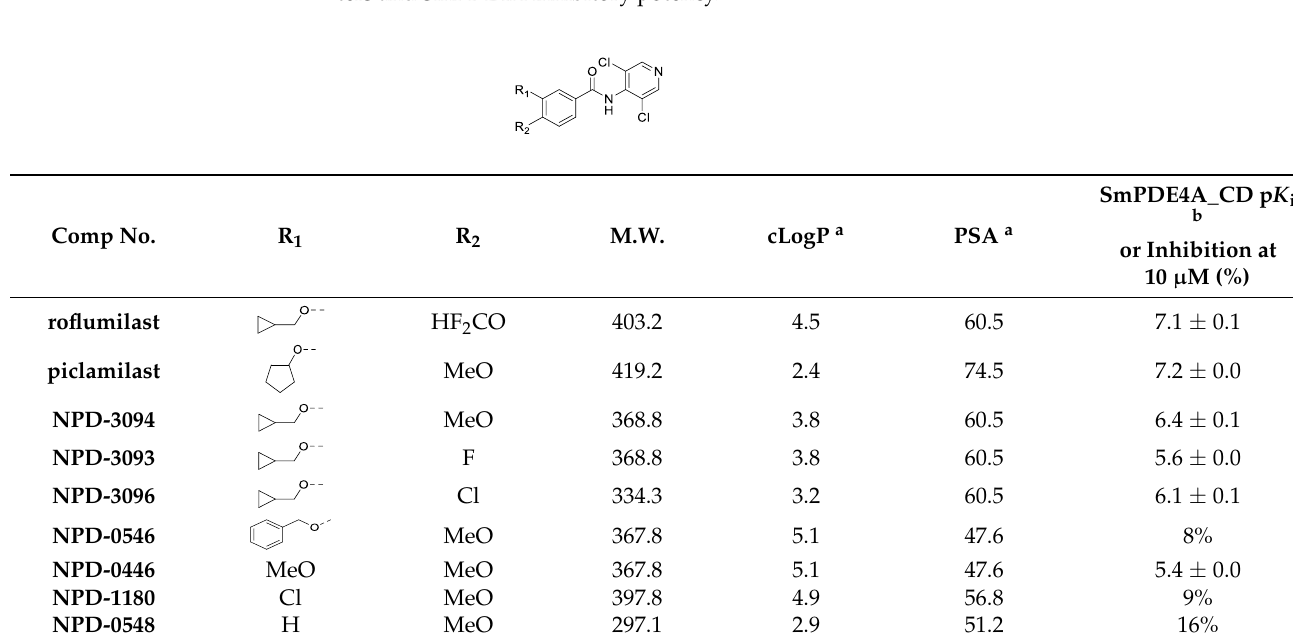
Table 2. Variations of the R 1 and R 2 groups of roflumilast and the effect on physicochemical param- eters and SmPDE4A inhibitory potency.